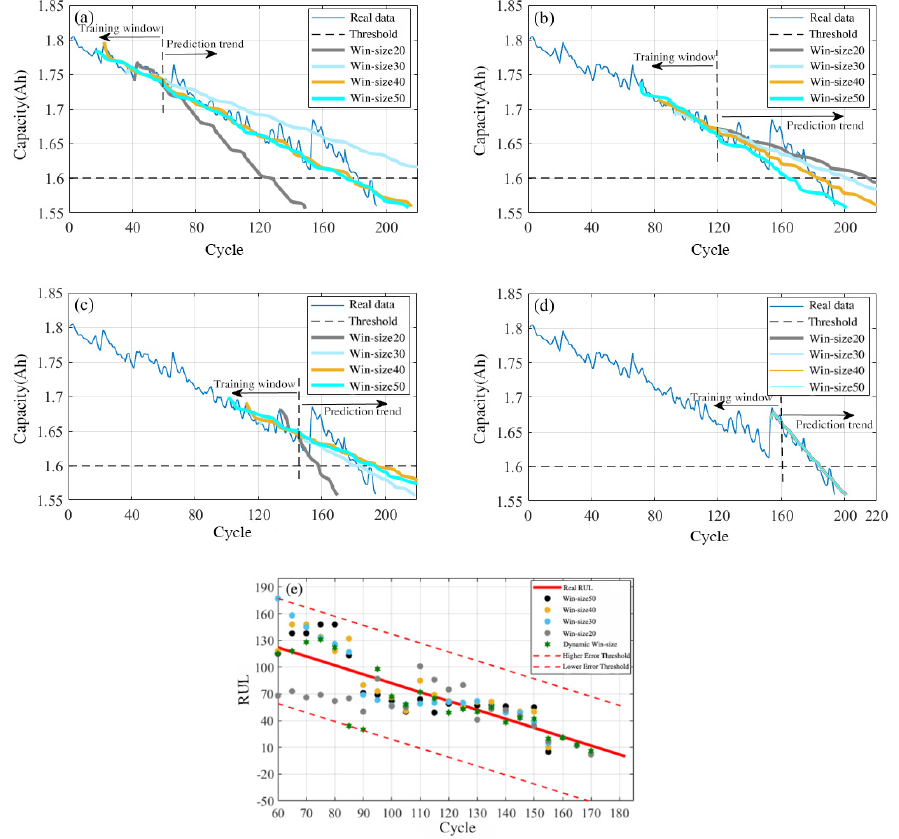
Figure 5. RUL prediction results of No. 36 with a dynamic window size: ( a ) starting cycle of 60; ( b ) starting cycle of 120; ( c ) starting cycle of 150; ( d ) starting cycle of 160; ( e ) RUL prediction results.